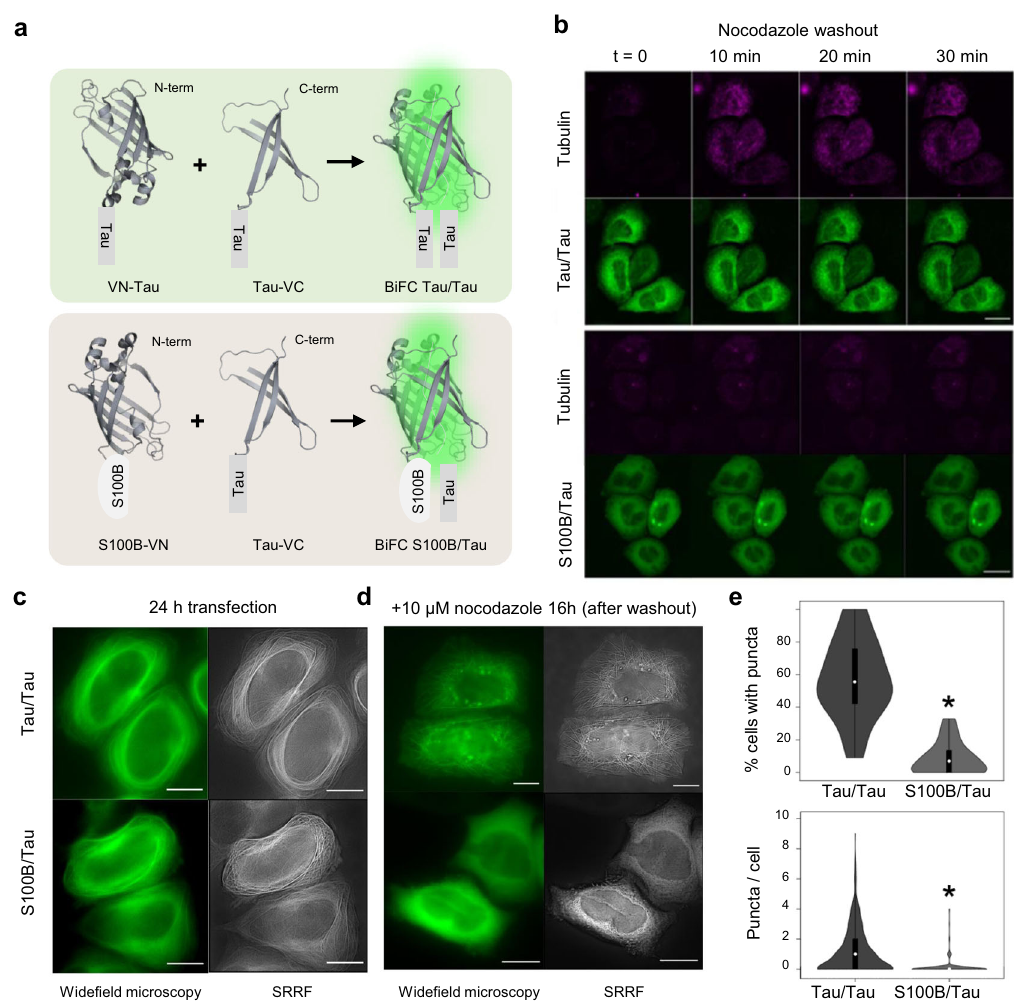
Fig. 1 S100B and tau colocalize in living cells and interactions persist upon microtubule destabilization. a Representation of N- and C-terminal halves of Venus constructs fused to tau and S100B termini and gain of fl uorescence based on bimolecular fl uorescence complementation. b HeLa cells were transfected with the BiFC constructs tau/tau and S100B/tau and incubated with 10 µ M of nocodazole for 16 h. Nocodazole was then removed, and cells were visualized immediately after washing out nocodazole ( t = 0) in time lapse for 30 min. Scale bar: 20 µ m. c , d Wide- fi eld microscopy and super- resolution radial fl uctuations (SRRF) reconstruction of HeLa cells ( c ) after 24 h of transient transfection with the BiFC constructs tau/tau and S100B/tau; and ( d ) after 16 h of incubation with 10 µ M of nocodazole, imaged ~15 min after washout. Scale bar: 20 µ m. e Violin-plot representation of cells forming puncta (top panel) and number of puncta per cell (bottom panel) after 16 h of incubation with 10 µ M of nocodazole. Plots are presented with fl oating boxes showing mean (white dot) and 1st and 3rd quartiles ( fl oating black boxes). Minimum and maximum values of the distribution are shown as the bottom and top of the violin plot. The number of cells analyzed was 927 (tau/tau) and 873 (tau/S100B) in a total of 65 pictures/group from 4 independent experiments. Data were analyzed by means of a two-tailed t – student test. *, signi fi cant versus tau/tau, top p = 0.0097 and bottom p = 3.6673 × 10 − 34